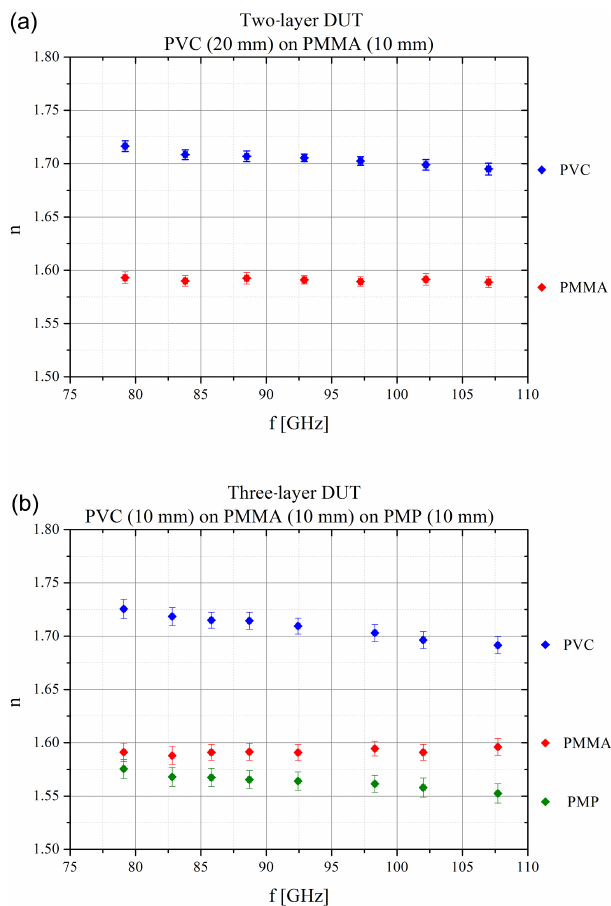
Figure 6. (a) Dispersion of different plastics measured from a double-layer structure. (b) The refractive index of PMP measured from a three-layer sample is overestimated compared to the single- disc measurements. Table 2. Conductance and pH values of the different solutions. DUT